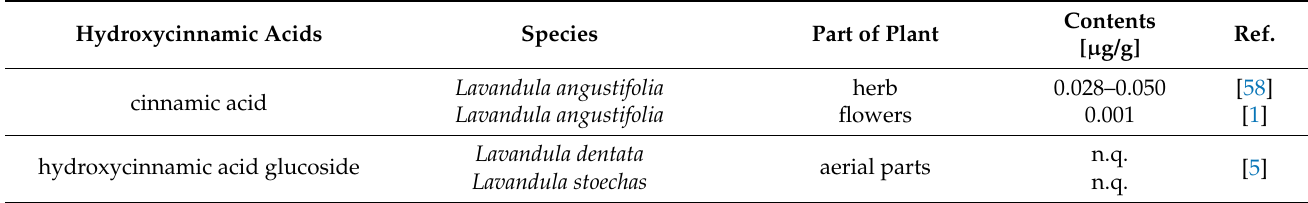
Table 3. Hydroxycinnamic and hydroxybenzoic acids in different species of